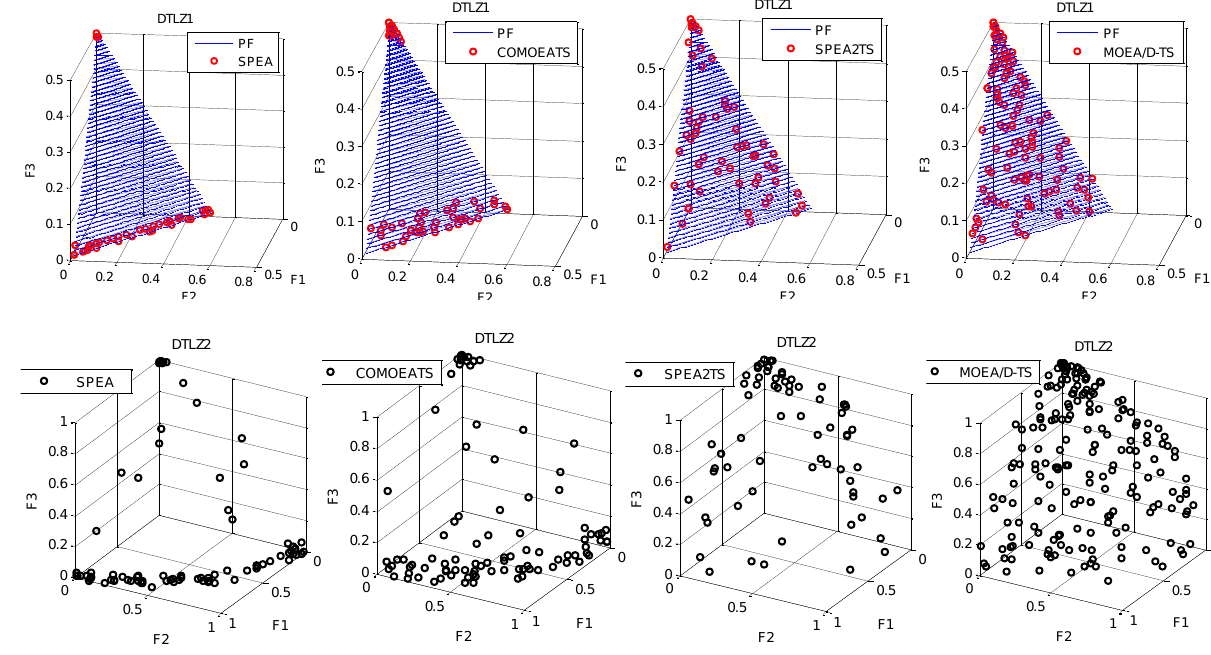
Figure 4. Solutions obtained by SPEA, COMOEATS, SPEA2TS, and MOEA/D-TS on DTLZ test